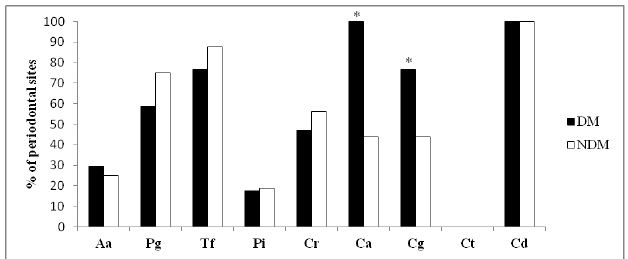
Fig. 1 - Frequency of periodontal sites harboring Aggregatibacter actinomycetemcomitans (Aa), Porphyromonas gingivalis (Pg), Tannerella forsythia (Tf), Prevotella intermedia (Pi), Campylobacter rectus (Cr), Candida albicans (Ca), Candida glabrata (Cg), Candida tropicalis (Ct) and Candida dubliniensis (Cd) in the DM and NDM groups. *Statistically significant differences were found between the groups for Ca and Cg, according to χ2 tests (test, p <0.05).